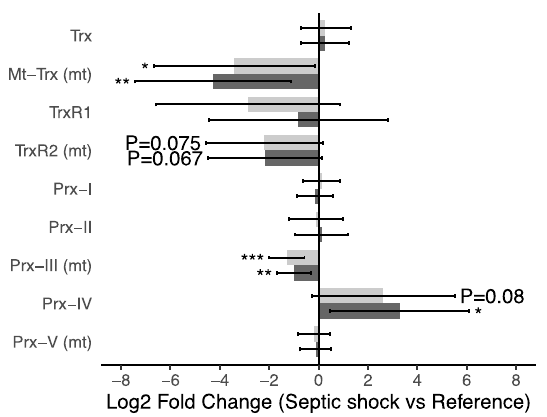
Figure 5. Alterations of the antioxidant and ROS detoxifying proteins and metabolites. The bar represents the mean difference (Log 2 Fold Change) between the S group and the two control groups, the error bar represents the 95% confidence interval. N = 31 patients analyzed for the proteomics (Septic shock n = 12, cardiogenic shock n = 9, brain dead n = 10) and N = 40 for the metabolomics (Septic shock n = 17, cardiogenic shock n = 6, brain dead n = 17). * p < 0.05; ** p < 0.01; *** p < 0.001 (Tukey’s post-hoc test, Group S versus Reference). Glrx, Glutaredoxin; GPx, Glutathione peroxidase; GR, Glutathione disulfide reductase; GSH-S,